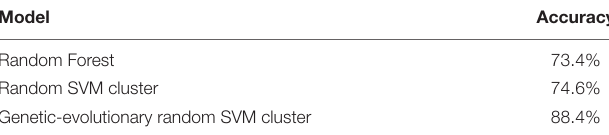
TABLE 2 | Mean accuracies of various model